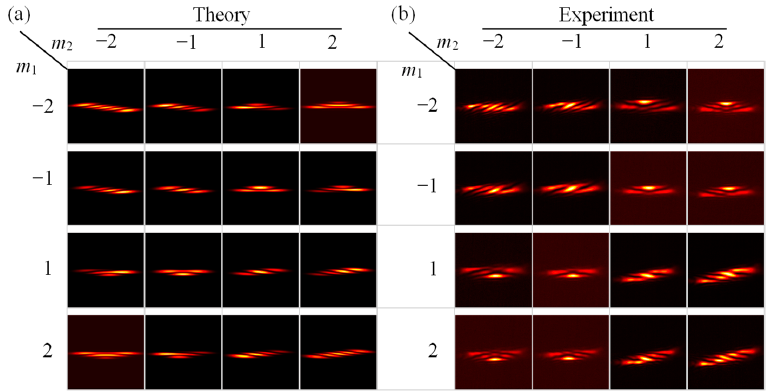
Figure 8. ( a ) Theoretically simulated and ( b ) experimentally measured intensity patterns of off-axis double vortex beams with different values of m 1 and m 2 focused by a tilted convex lens when λ = 1064 nm, w = 2.5 mm, f = 30 cm, z 0 = 50 cm, z = 28 cm, θ = 21°, x 1 = x 2 = 0, and Δ = 0.5 w . As shown in Figure 6, near the focus of the tilted convex lens, the intensity distribution of the off-axis single vortex beam presents a bright and dark striped shape, and the magnitude of the TC of the beam is equal to the number of bright stripes minus one. The direction of the stripes is related to the TC’s sign, and the corresponding stripes of vortex beams with different TC signs are inclined in opposite directions. When the phase singularity is located at the geometric center of the beam, the intensity distribution detected near the focus of the tilted lens is shown in the third line of Figure 6. Since the on-axis vortex beam is center symmetric, the intensity distribution of the inclined stripe is also uniform. In this case, the TC of on-axis vortex beams can be accurately measured by counting the number of inclined dark stripes. When the vortex is off-axis, as shown in Figure 6, the intensity of the inclined stripes will no longer be uniform, and the offset of the phase singularity results in the offset of intensity near the focal field of the tilted lens. Although the stripes are no longer uniform, the TC of an off-axis single vortex beam is still equal to the number of bright stripes minus one, which is the same as that of an on- axis vortex beam [27]. That is to say, the TC of off-axis single vortex beams is still equal to that of on-axis vortex beams (see Equation (6)). After discussing the off-axis single vortex beam, we focus on the TC detection of the off-axis double vortex beam. Figures 7 and 8 show the theoretically simulated and